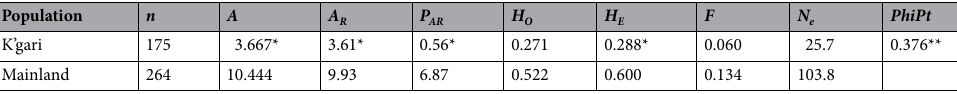
Table 1. Summary of genetic measures for the K’gari and mainland dingo populations. n , number of dingoes sampled per population; A, mean number of alleles per locus; A R , allelic richness; P AR , private allelic richness; H O , mean observed heterozygosity; H E , mean expected heterozygosity; F , fixation index; N e , effective population size, statistically significant difference (*, p < 0.05; **, p < 0.001) between K’gari and